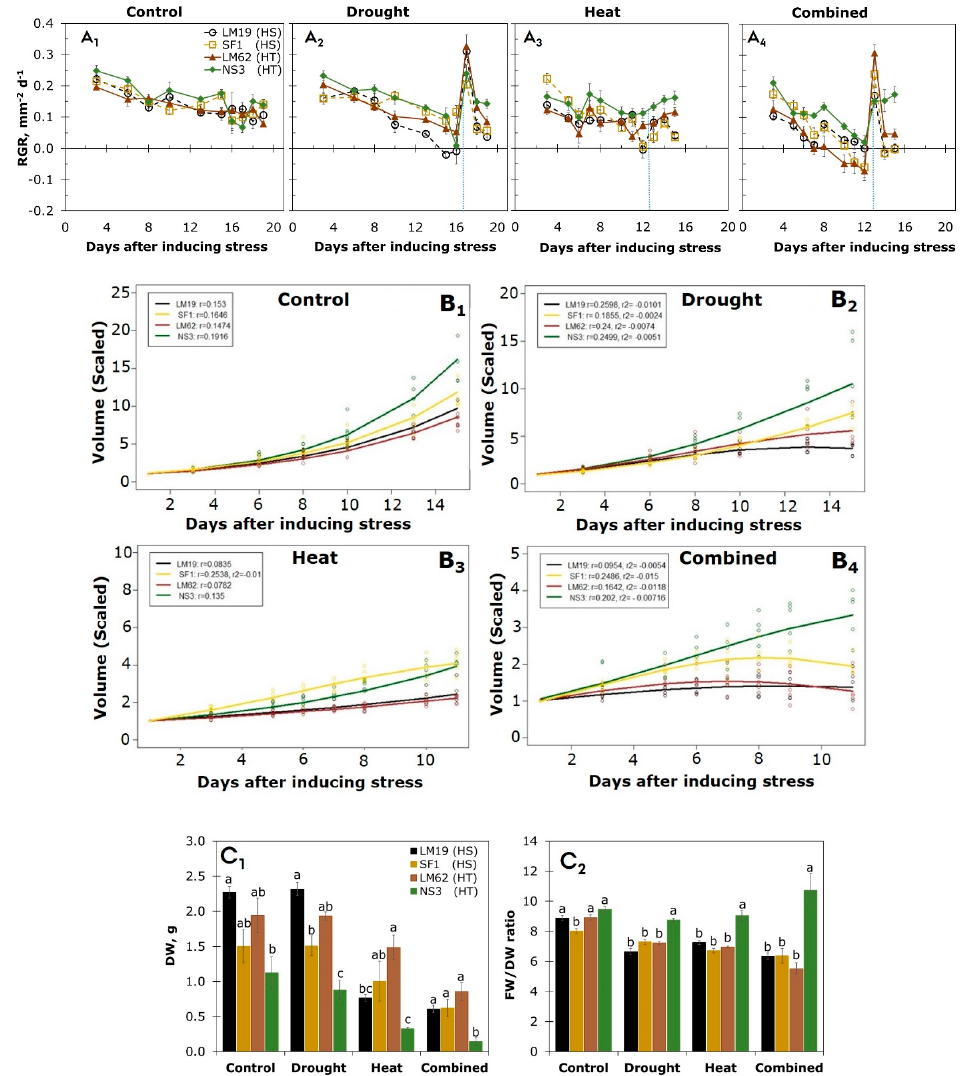
Figure 3. ( A 1–4 ) Relative growth rate (RGR) along days after inducing the stress treatments followed by three days of recovery in four wheat genotypes. HS represents heat-sensitive genotypes (open symbols, dashed lines) and HT represents heat-tolerant genotypes (closed symbols, solid lines). Blue dotted line denotes the recovery phase. The data represent mean values ± S.E.M. ( n = 5). ( B 1–4 ) Growth models for plant volume in different treatments. Bold lines represent the models and circles point out the scaled data. In the legends the estimated coefficients of the growth models are presented (Equations (1) and (2) described in materials and methods). ( C 1,2 ) Dry weight (DW) and ratio of fresh weight/dry weight (FW/DW) from destructive harvest at the last day after inducing the stress. The data represent mean values ± S.E.M. ( n = 4). Different small letters indicate significant differences in each genotype by using Tukey’s test at level p < 0.05.